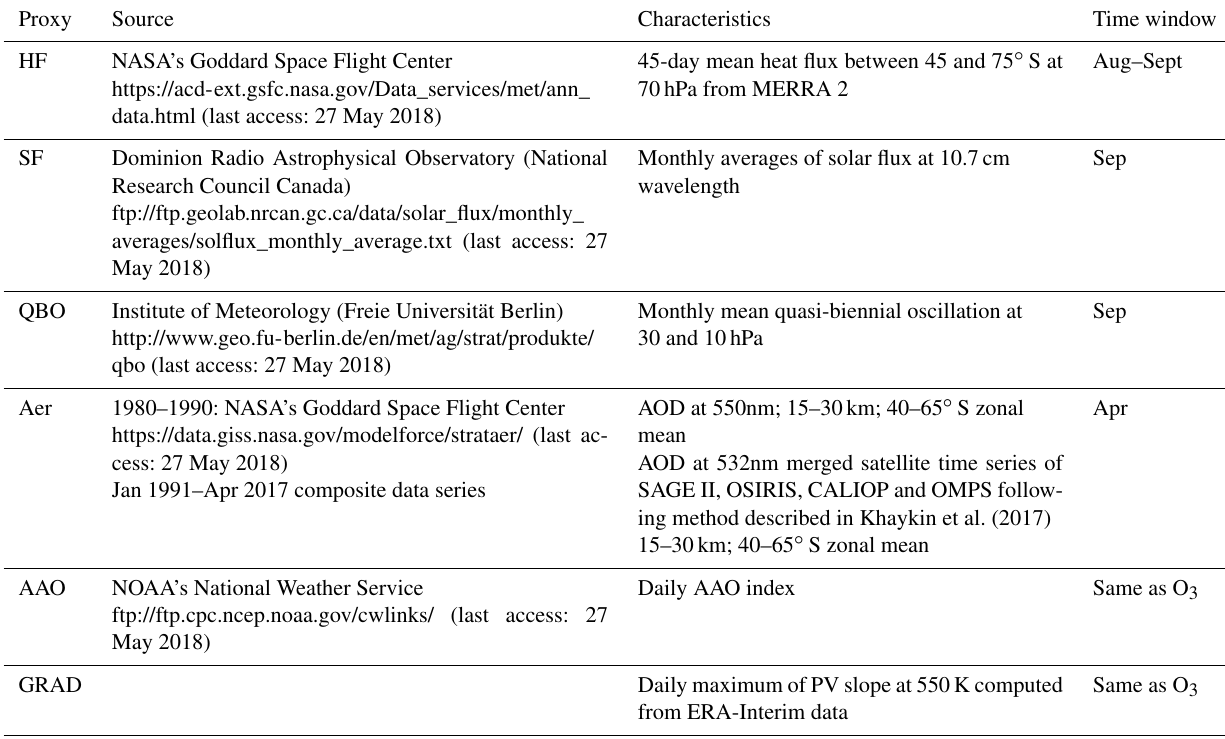
Table 1. Information of proxies (source, characteristics and time window for the mean yearly value). Proxy Source Characteristics